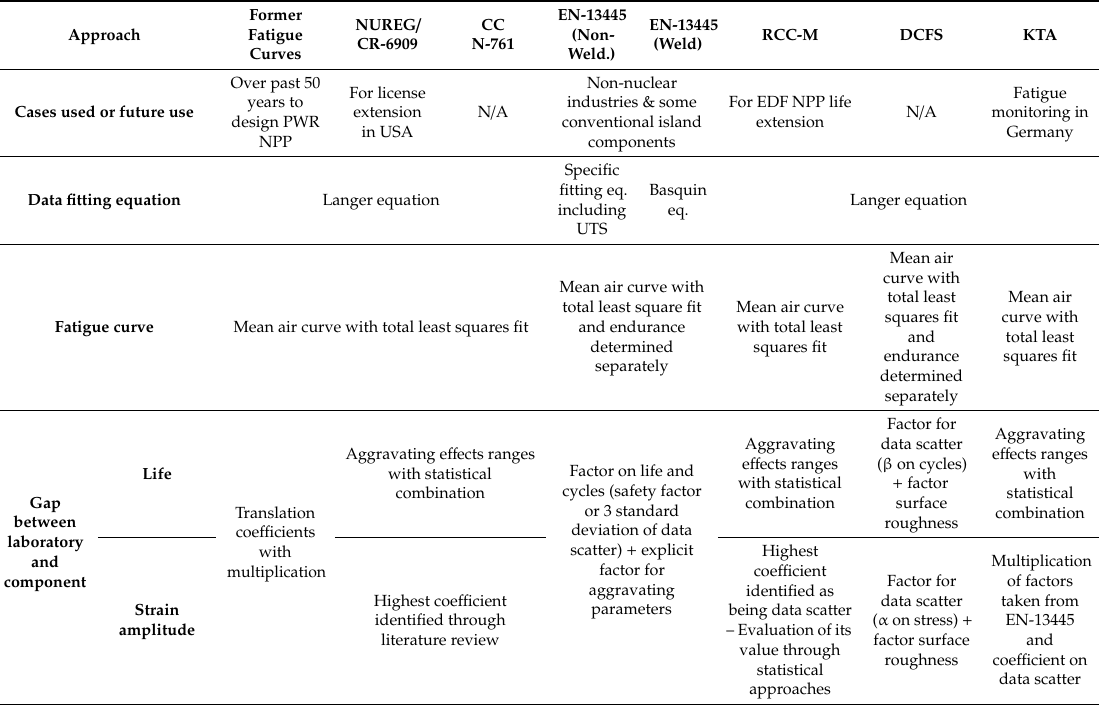
Table A1. Overview of the di ff erent EFA